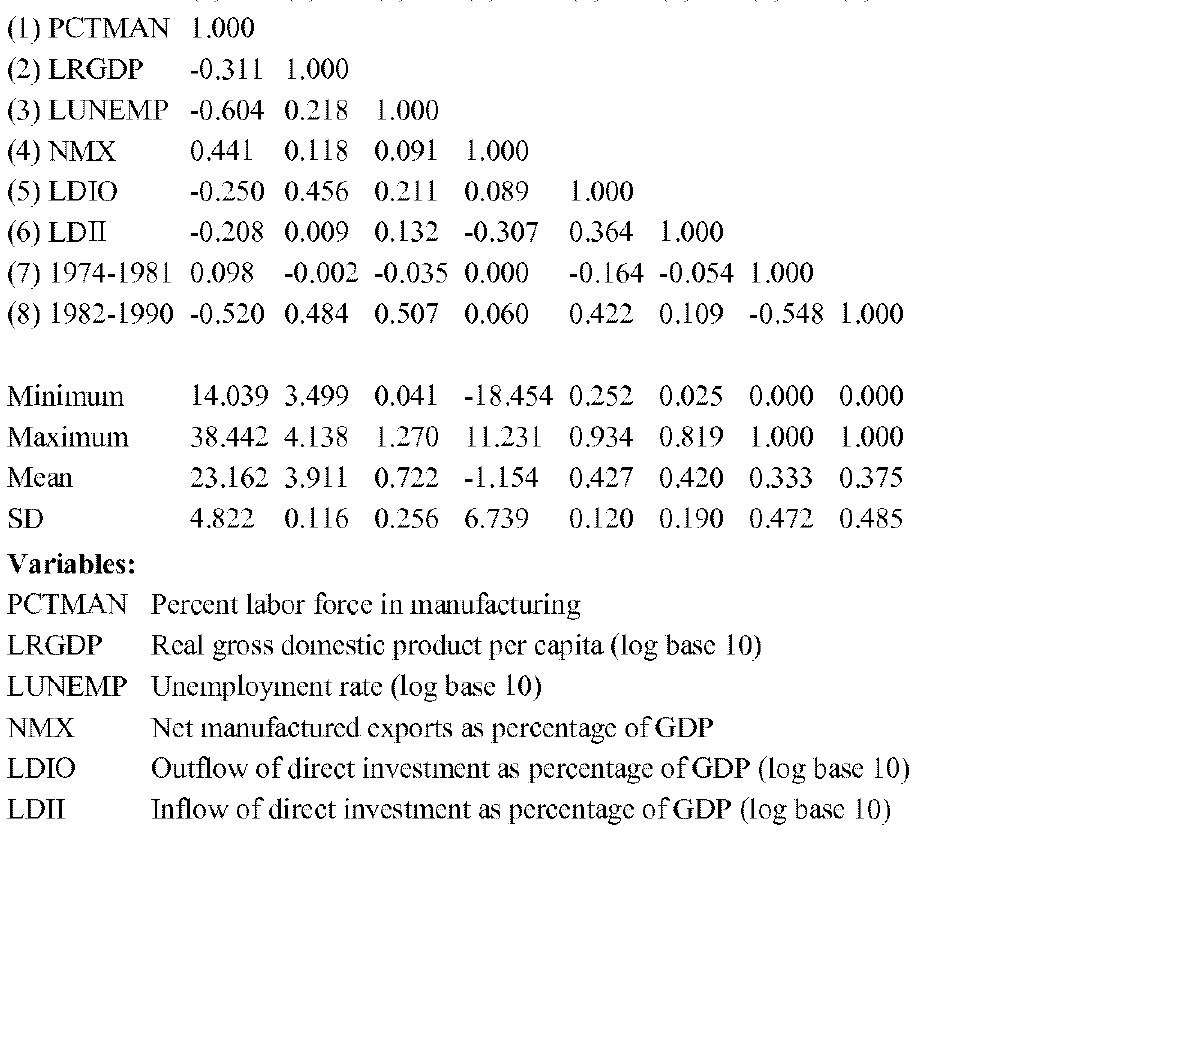
Table 4. Correlations and basic statistics for variables in the analysis (N=408)